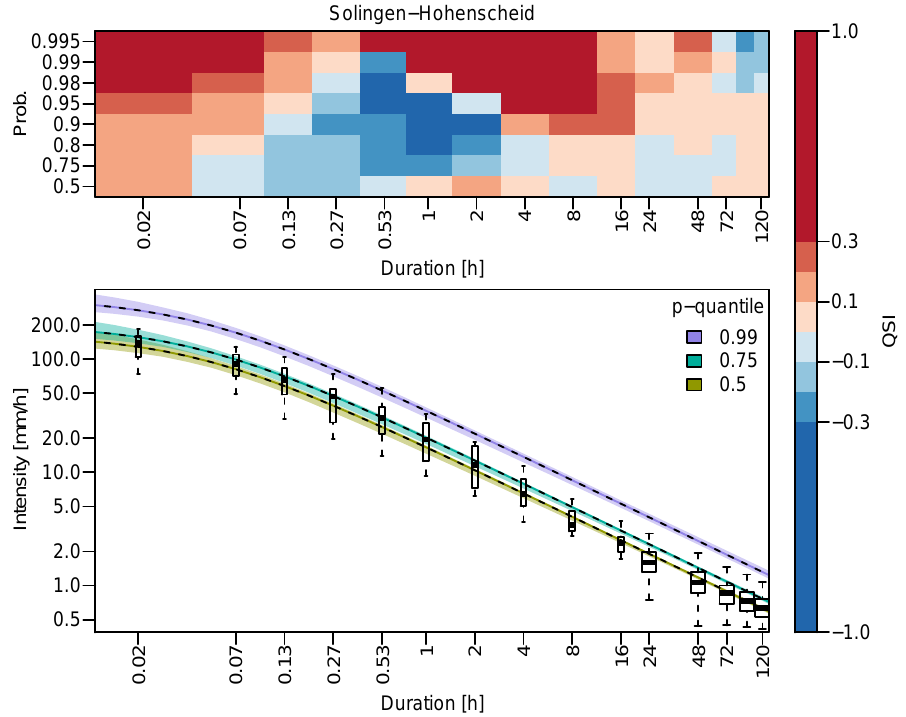
Figure 8. IDF-curve estimate for Solingen-Hohenscheid (marked with white square in Figure 1) (lower panel) obtained by using the spatial d-GEV (black dashed lines) and their 95% confidence intervals (colored areas). Observations are shown as boxplots, where the width of the box is proportional to the number of data points available at a certain duration. The upper panel shows the corresponding QSI values at that station following the presentation of Figure